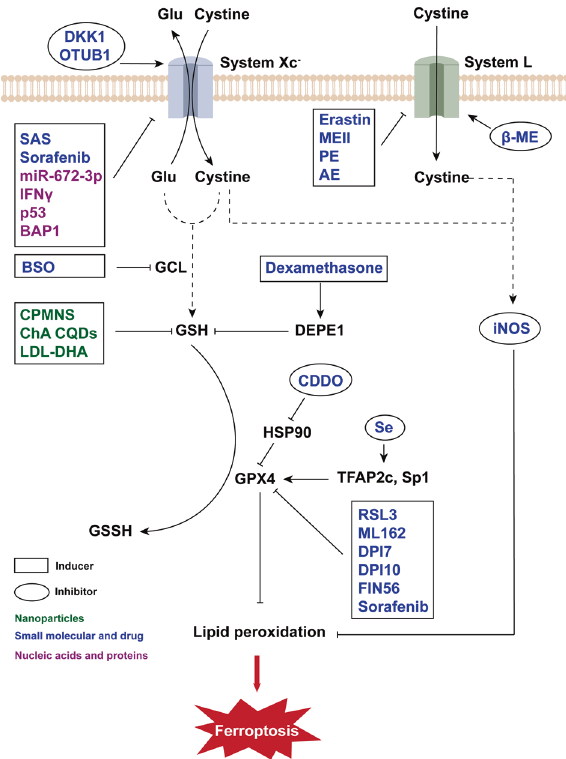
Fig. 3 Regulators of ferroptosis through GSH/GPX4 axis. GSH is a crucial reductant, whose production involves amino acid transpor- ters and a variety of enzymes, such as System Xc − and GPX4, which are important targets for regulating ferroptosis. In addition, in speci fi c cells like M1 tumor-associated macrophages, iNOS can catalyze the production of another reductant NO to